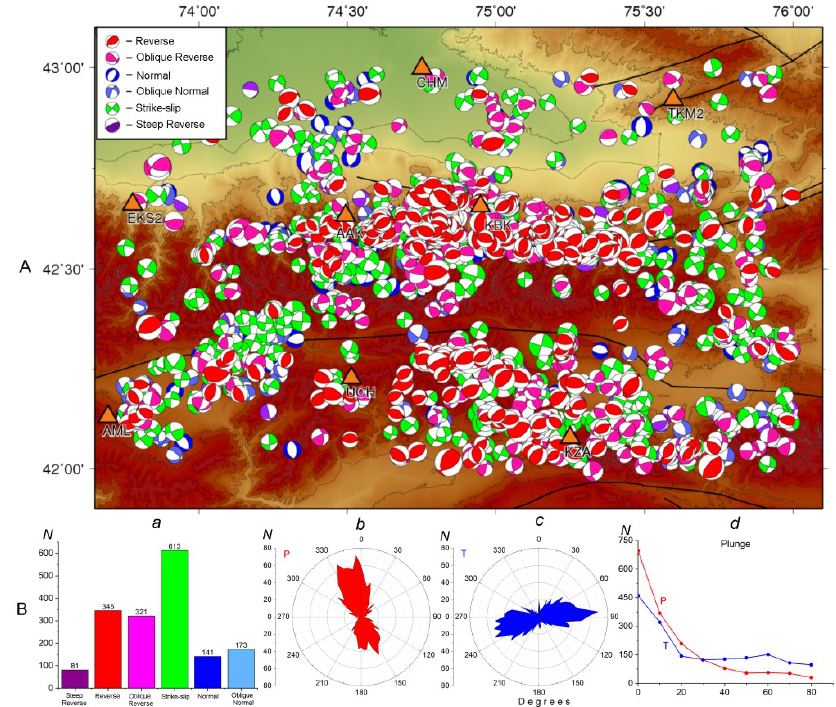
Fig. 4. A – epicentral position and focal mechanisms of earthquake centers (1674).  - Stations of the KNET network. В: a - ratio of the number of earthquakes by type of movement; b- diagrams of distribution of compression axes; c - axis of tension; d - the angles of immersion of these axes.